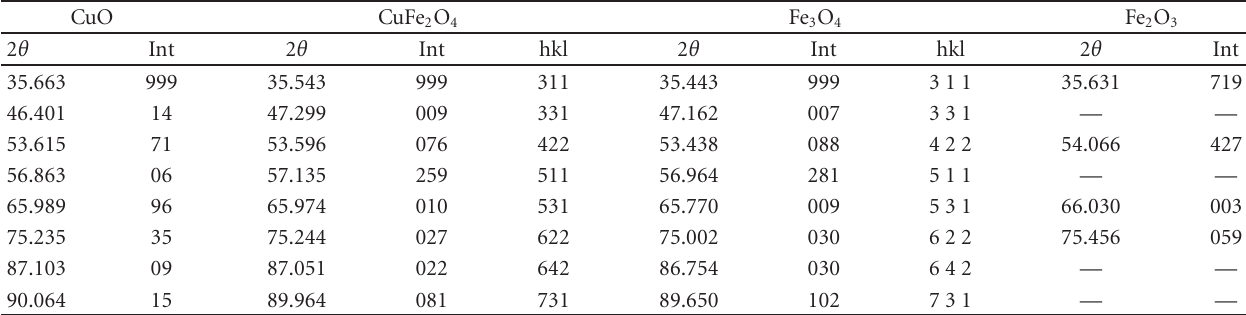
Table 1: Peak position, intensity, and hkl values of possible secondary phases in Fe-doped CuO from XRD pattern.